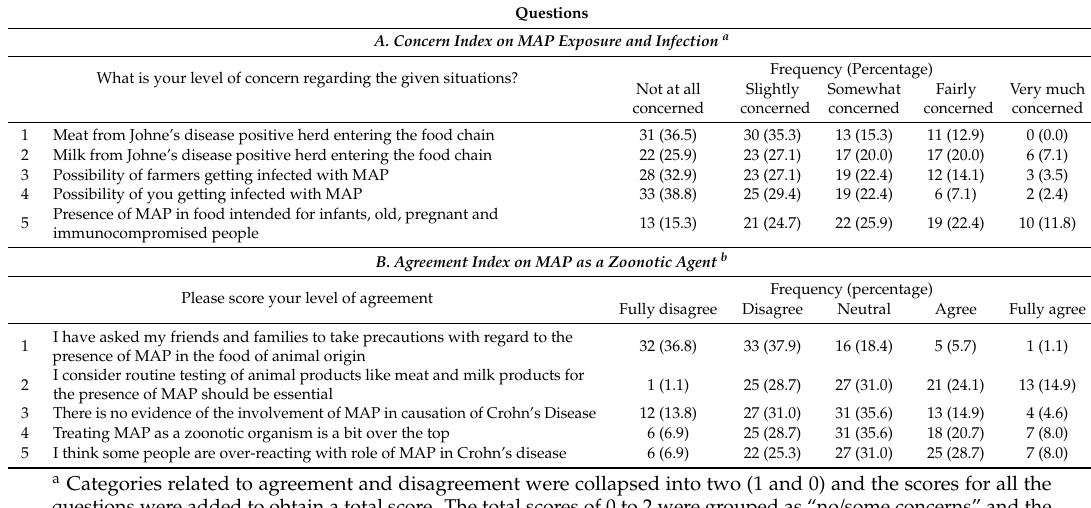
Table 1. Responses for five concern measures and five agreement measures that were combined to obtain two index measures in the study conducted in Australia in